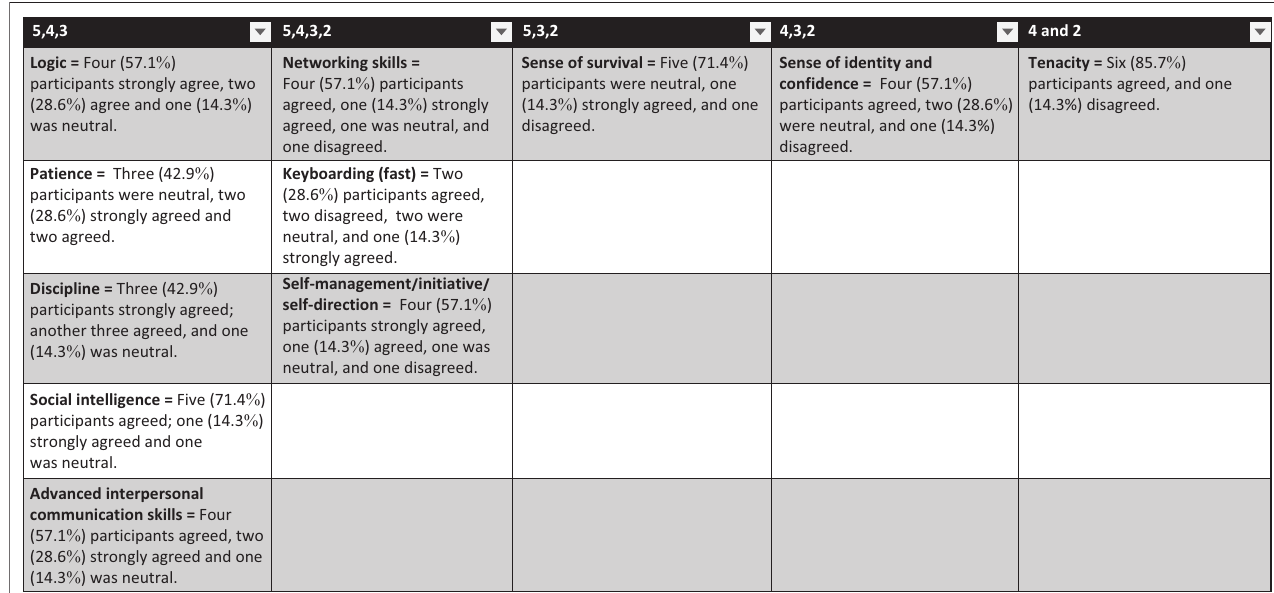
FIGURE 2: Results of aptitude skills with no consensus.